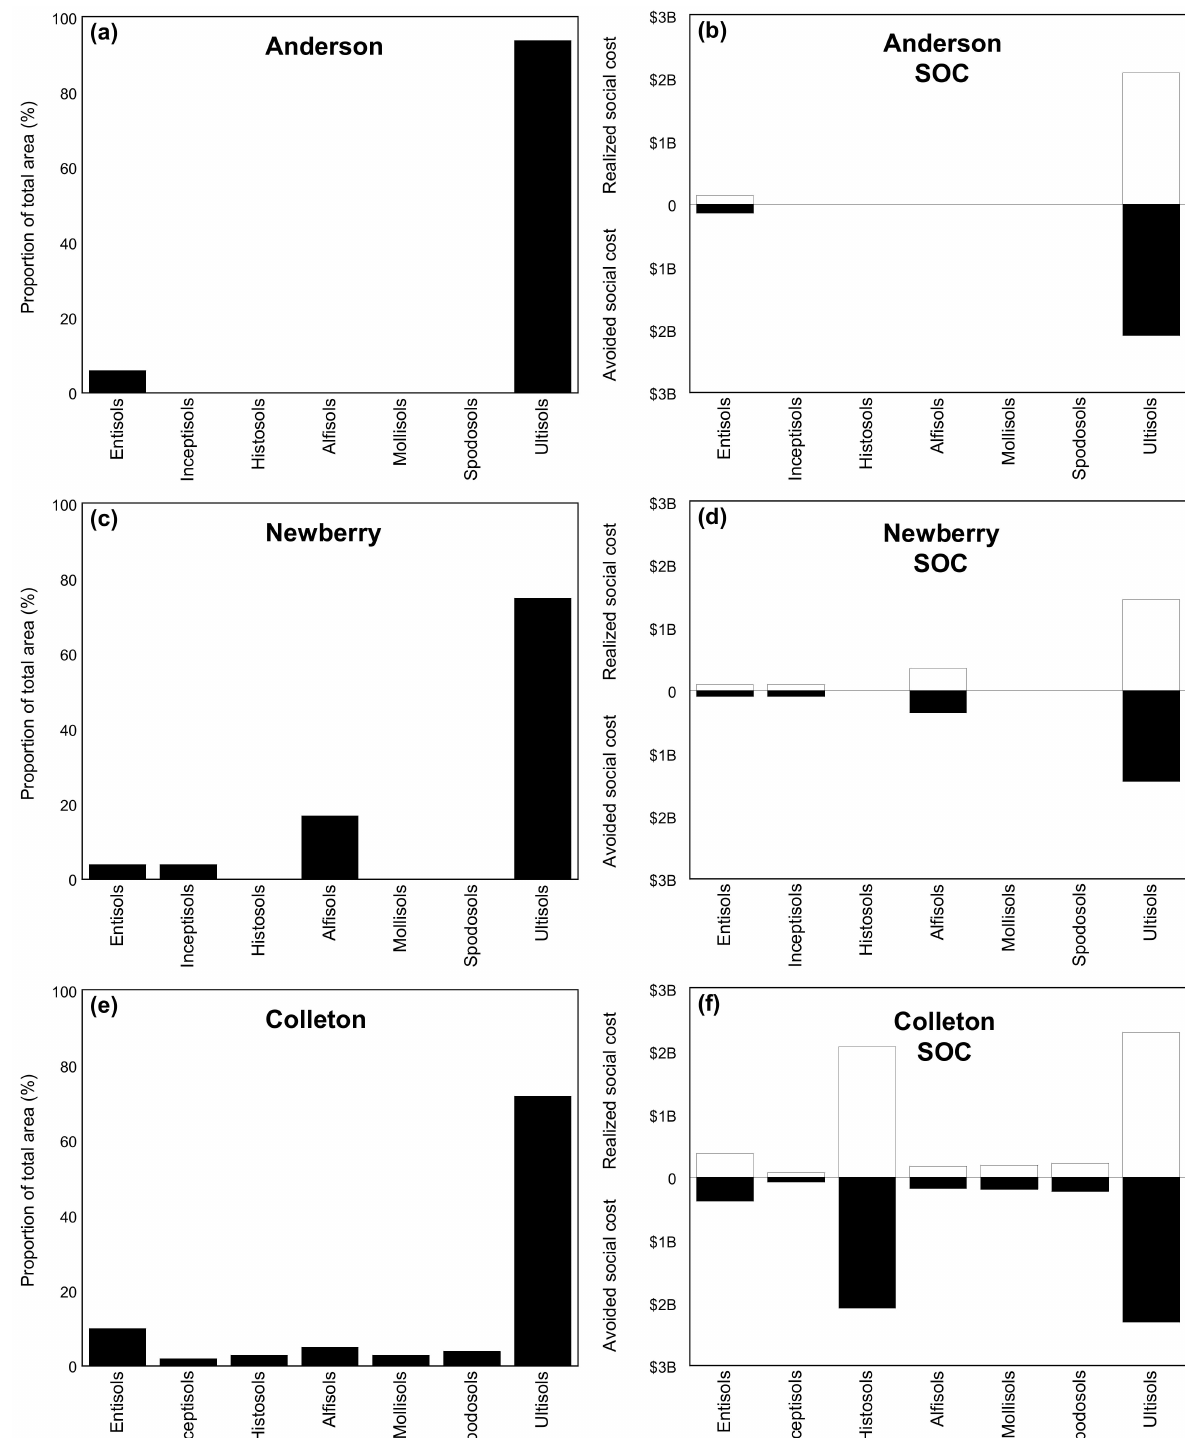
Figure 5. Diagram showing how the “portfolio-effect” and “distribution-effect” of pedodiversity can vary by county: ( a , c , e ) pedodiversity by soil order area; ( b , d , f ) value of soil organic carbon (SOC) storage in the upper 2-m depth based on avoided or realized the social cost of CO 2 (SC-CO 2 ) of $46 (USD) per metric ton of CO 2 [17] by soil order. Note: B = billion = 10 9